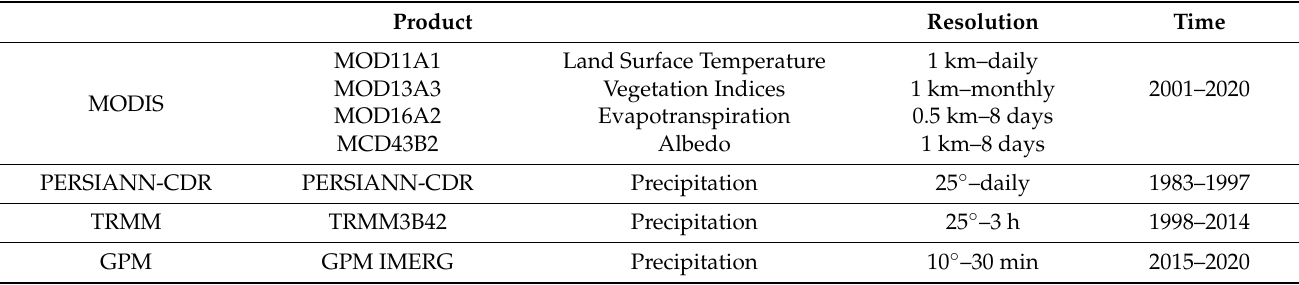
Table 1. Satellite data information used in this study.